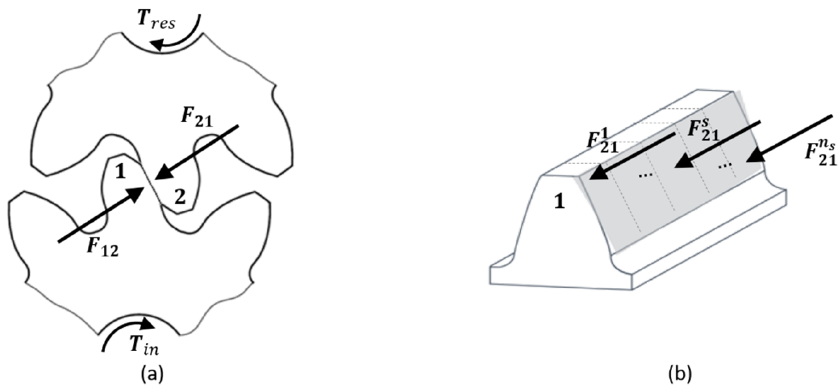
Figure 3. Contact problem: ( a ) external forces acting on the meshing gears; ( b ) slicing approach. In such a context, the gear contact is solved using three steps: